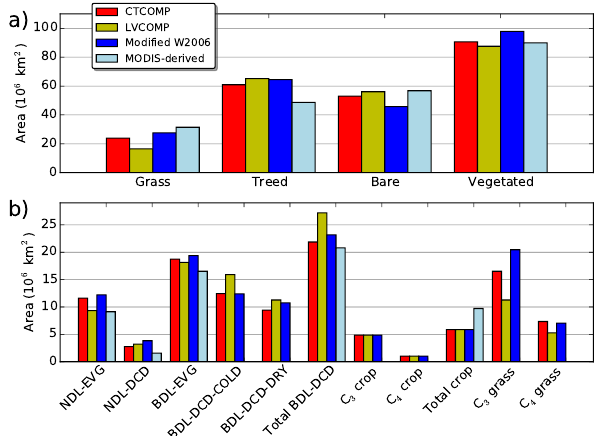
Figure 1. Comparison of observation-based and simulated global areal extent of grass, treed, bare ground and total vegetated area (sum of grass, treed and crop areas) from pre-industrial simulations that use the CTEM competition scheme (modified L–V; CTCOMP) and the unmodified L–V equations (LVCOMP) (a) . (b) Shows the comparison for areal extent of individual PFTs. The observation- based estimates are from the modified Wang et al. (2006) data set (corresponding to year 1861) and the MODIS-derived product (which corresponds to the present